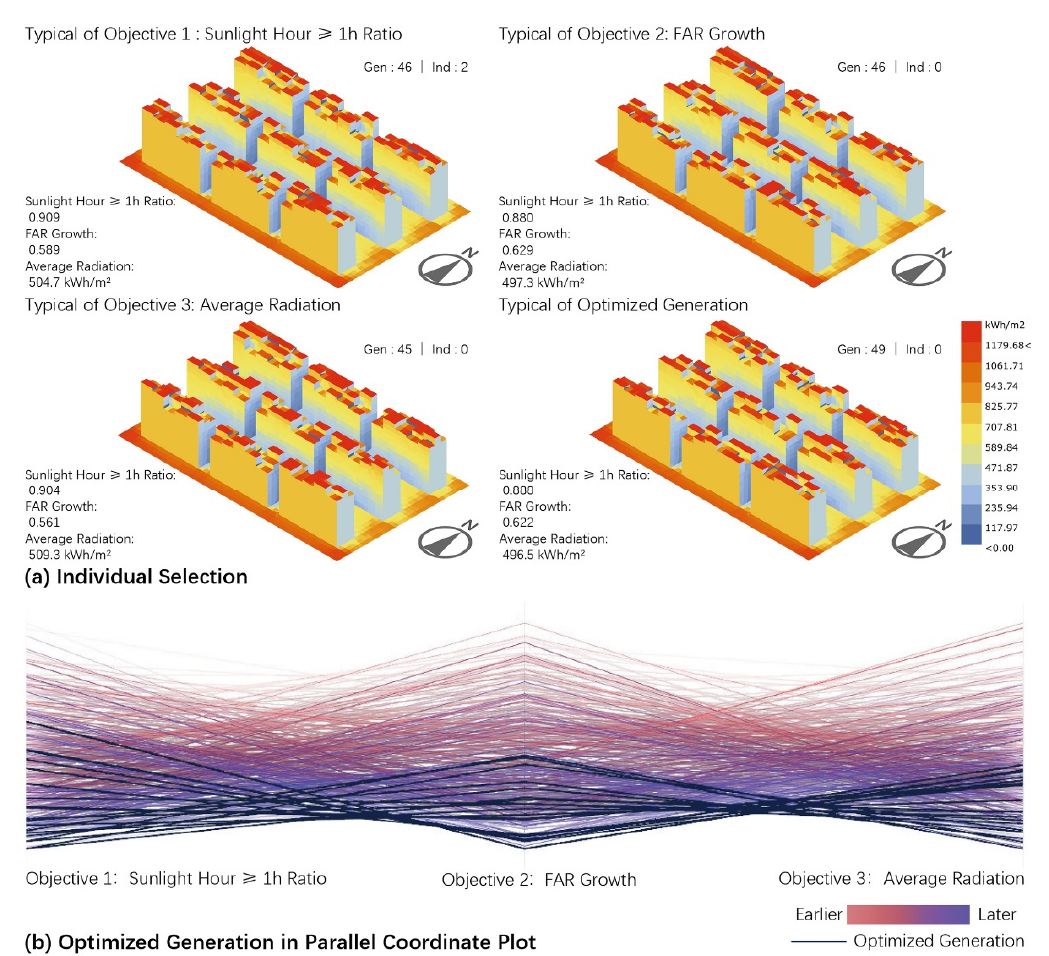
Figure 8. Selected solutions of the vertical addition mode.